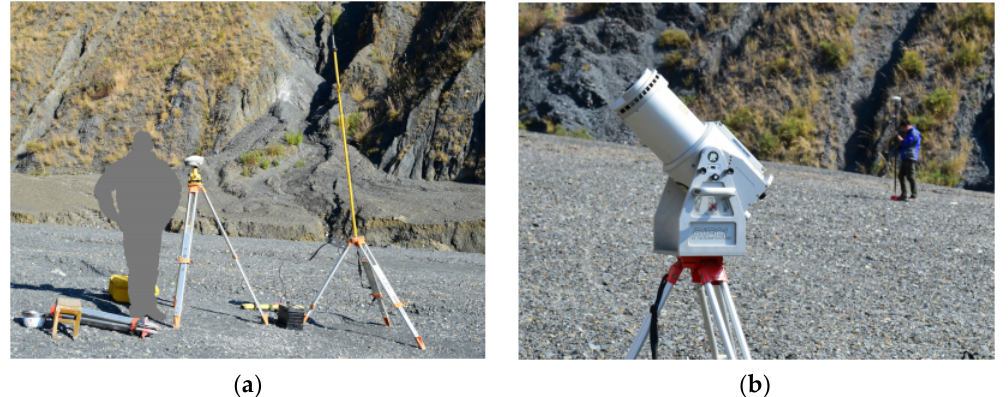
Figure 5. Ground LiDAR survey in the Jiangjia Gully area showing ( a ) DGPS base station ( b ) RIEGL Z-6200 laser scanner.